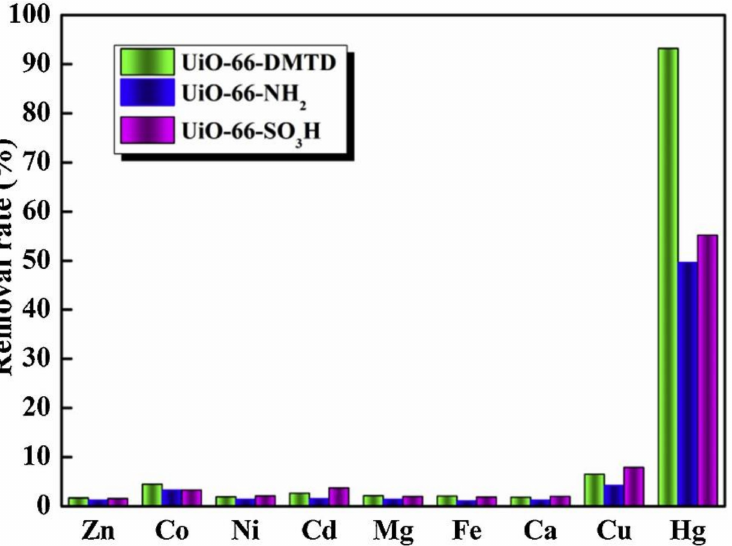
Figure 10. Selective removal of Hg 2+ by UIO-66-NH 2 , UIO-66-SO 3 H and UIO-66-DMTD (Repro- duced with the permission from Ref